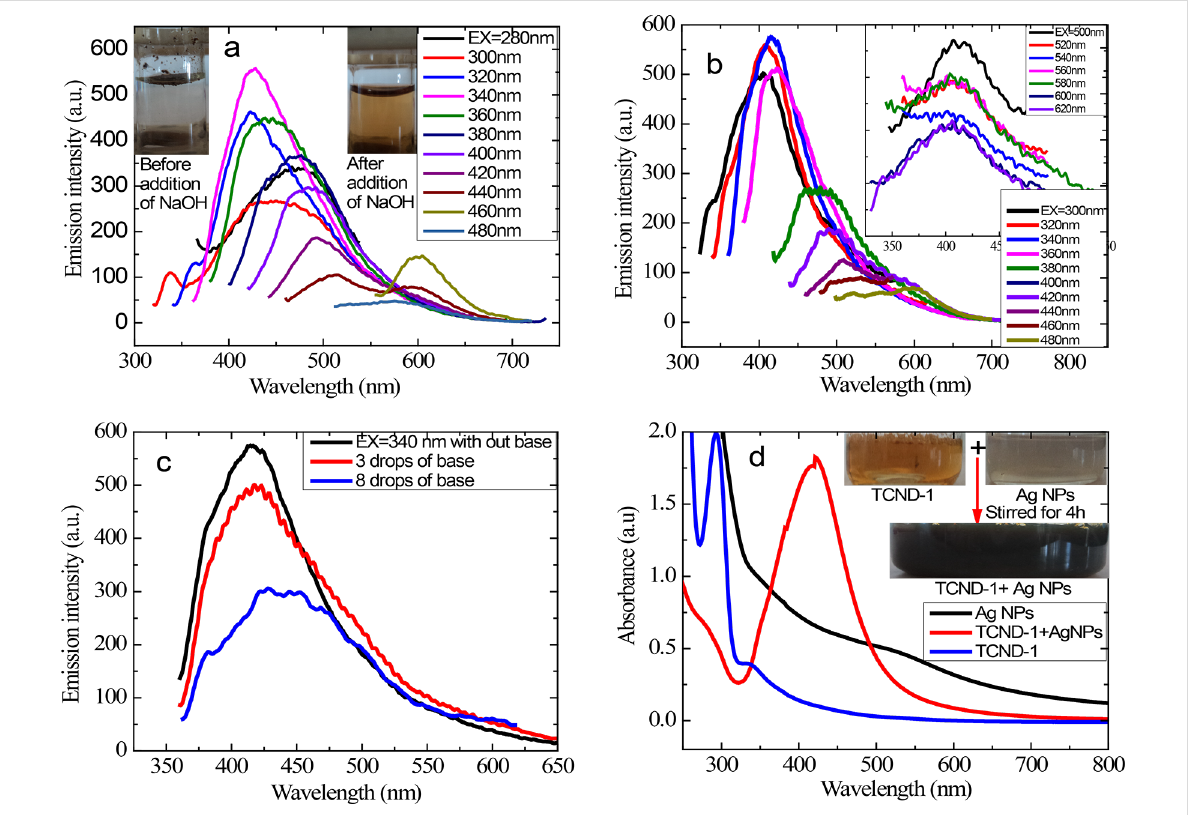
Figure 8: PL emission spectra of TCND-1 at different excitation wavelength (a) in aqueous solution under basic conditions (b) in ethanol solution and upconversion emission spectra shown in inset. (c) Emission spectra of TCND-1 at an excitation wavelength of 340 nm before and after addition of three and eight drops of base in ethanol. (d) Absorption spectra of Ag NPs, TCND-1, and the composite material in aqueous solution under basic conditions,